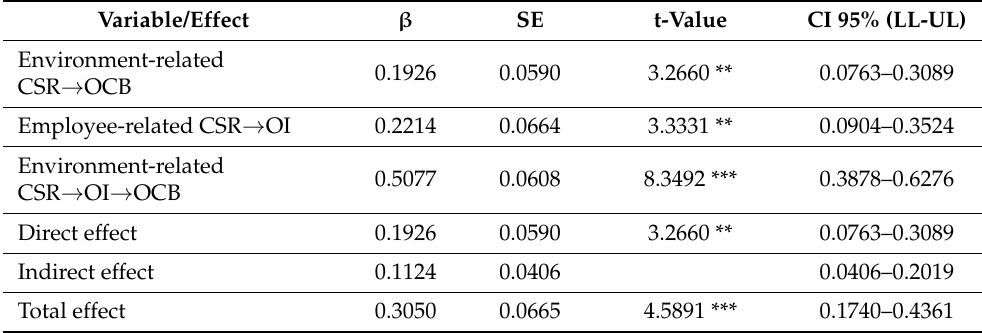
Table 4. Regression Coefficients, Standard Errors, and Model Summary Information (Mediation Model_Environment-related